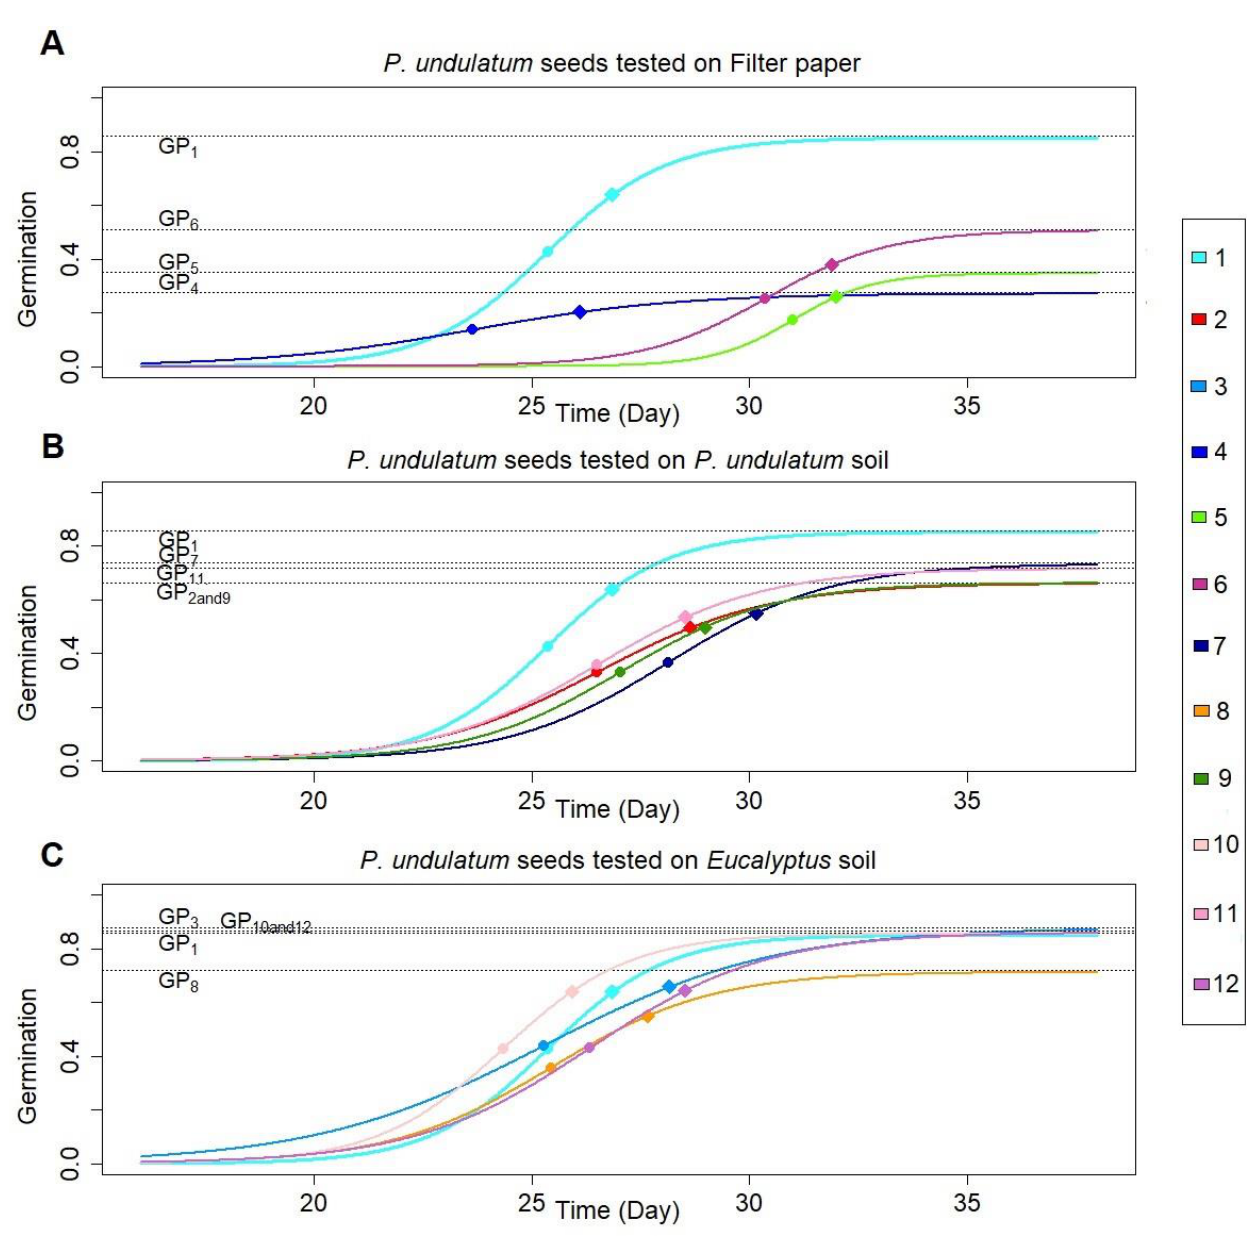
Figure 3. Panel A shows the overall temporal progression of Pittosporum undulatum seeds germi- nation for all combinations on Filter paper substrate: 1 — Filter paper Water; 4 — Filter paper L EL ; nation for all combinations on Filter paper substrate: 1—Filter paper Water; 4—Filter paper L EL ; 5 — Filter paper L PG ; 6 — Filter paper L PL . Panel B shows the curves obtained from seeds germinated 5—Filter paper L PG ; 6—Filter paper L PL . Panel ( B ) shows the curves obtained from seeds on P. undulatum soil substrate: 2 — P. undulatum soil Water; 7 — P. undulatum soil L EL ; 9 — P. undula-